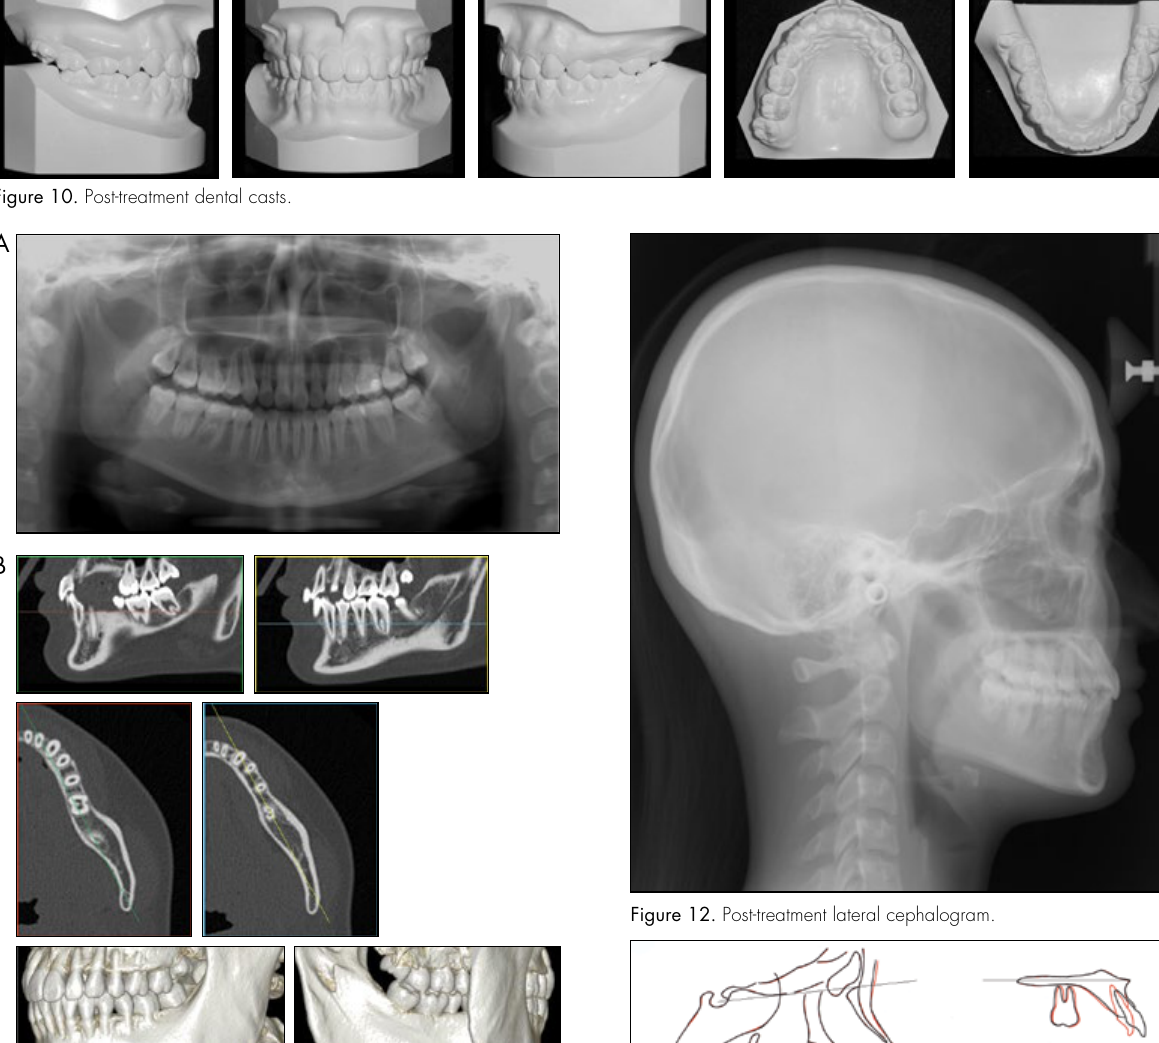
Figure 11. Post-treatment radiographs. a: Panoramic radiograph. b: Computed tomography.